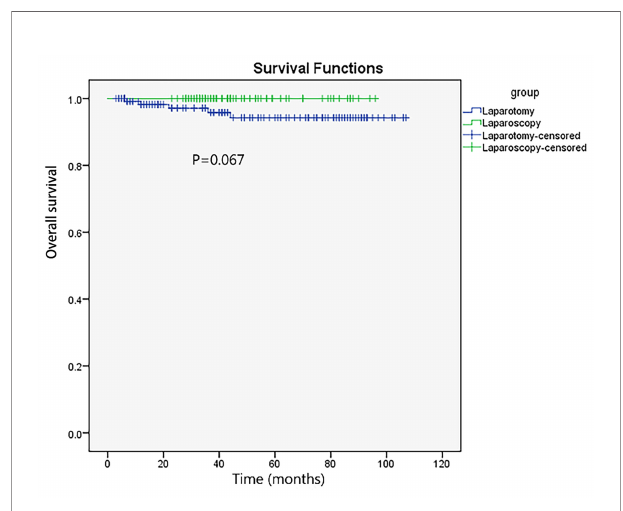
FIGURE 2 | Overall survival of laparoscopy and laparotomy in patients with early